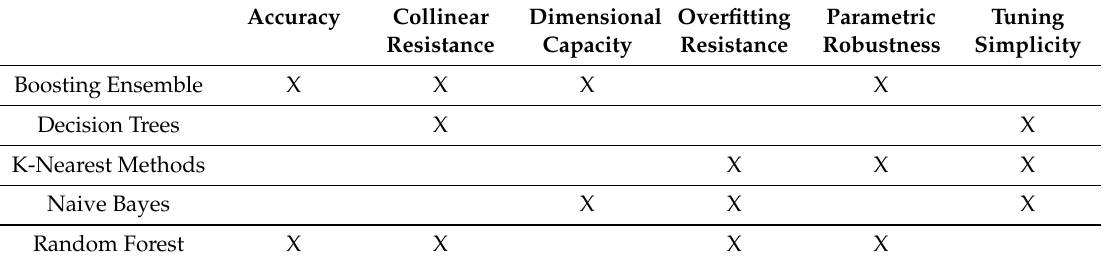
Table 8. Machine learning algorithm